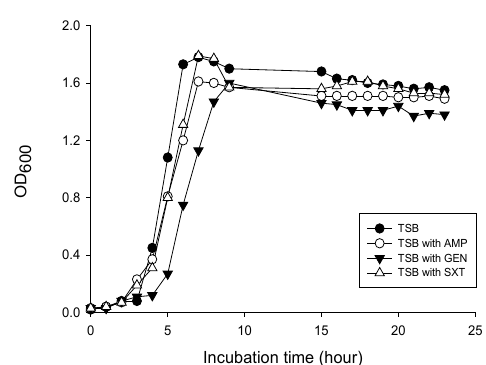
Figure 1. Growth of L. monocytogenes under antibiotic stress conditions. Bacteria were cultured in tryptic soy broth (TSB) without antibiotics, TSB with 0.25 μg/mL ampicillin (AMP), TSB with 0.25 μg/mL gentamicin (GEN), or TSB with 0.25/1.25 μg/mL trimethoprim/sulfamethoxazole (SXT) at 37 °C with shaking. Bacterial growth was measured at OD 600 at indicated time points. Data are representative of three independent experiments with similar results.